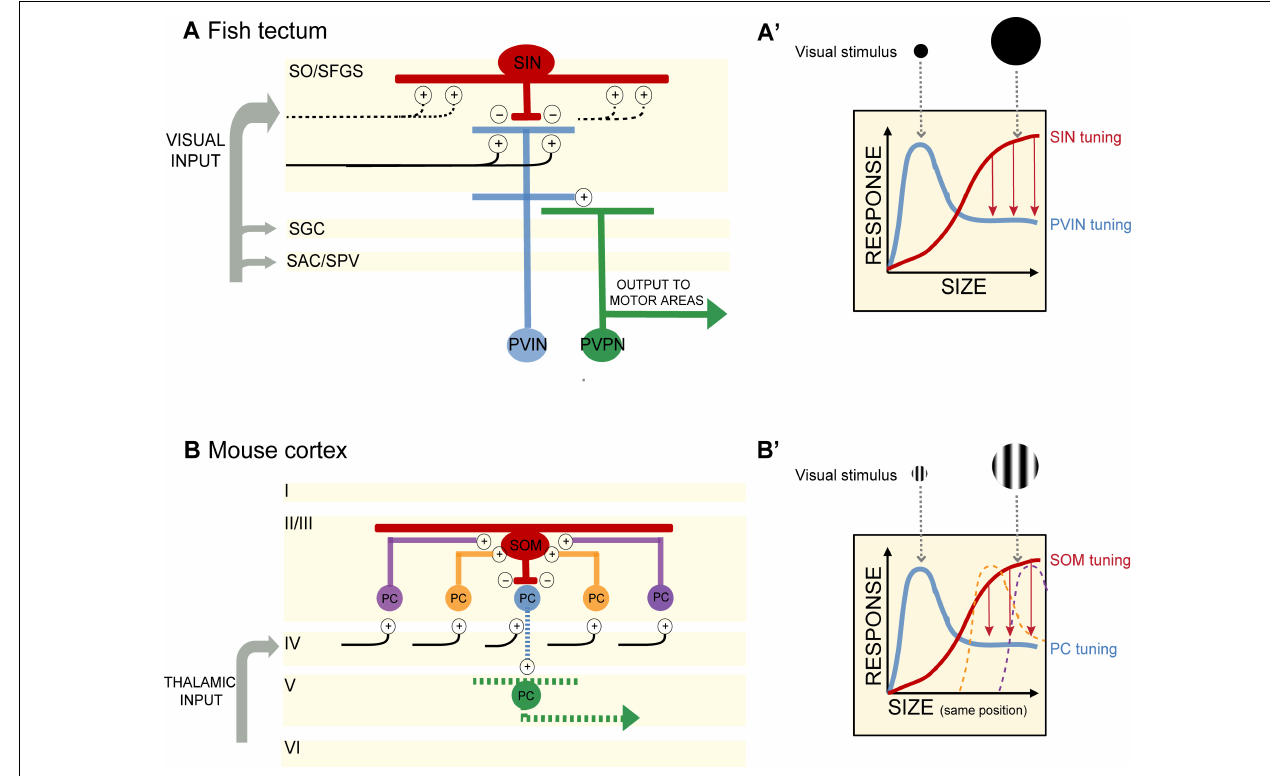
cells (PCs) in layer II/III. SOMs provide inhibition to neighboring layer II/III PCs, resulting in surround suppression and PC preferential tuning to smaller objects. Cortical layers I toVI are denoted. Plus and negative signs denote excitatory and inhibitory connections, respectively. Red denotes inhibitory interneurons. Excitatory PCs in layer II/III are colored in blue, orange, and purple (corresponding to their relative distance from the SOM). The central PC (shown in blue) receives surround suppression from the SOM. PCs in layerV are colored in green. For simplicity in this schematic, only connections pertaining to size filtering circuitry are shown. Projections of layer II/III PCs are not shown. Black lines depict input from the thalamus. Dashed lines indicate predicted, but not yet demonstrated synaptic connections. (B (cid:3) ) Schematic of SOM filtering in the visual cortex. Here the visual stimulus is a drifting grating (within a circular aperture) of increasing size. Size tuning of the central PC shown in ( B ; blue) is depicted here with a blue size-tuning curve. As the stimulus size increases beyond the size of the blue PC’s receptive field, the receptive fields of neighboring PCs are activated.The large visual stimulus occupies the same position in the visual field as the small stimulus, but increases in diameter thus encompassing multiple PC receptive fields (depicted here by the orange and purple size-tuning curves).These PCs provide excitatory drive to a SOM. SOM activation in turn provides surround suppression to the blue PC.The size-tuning curve of the SOM is depicted in red. Red arrows denote inhibition acting to sharpen